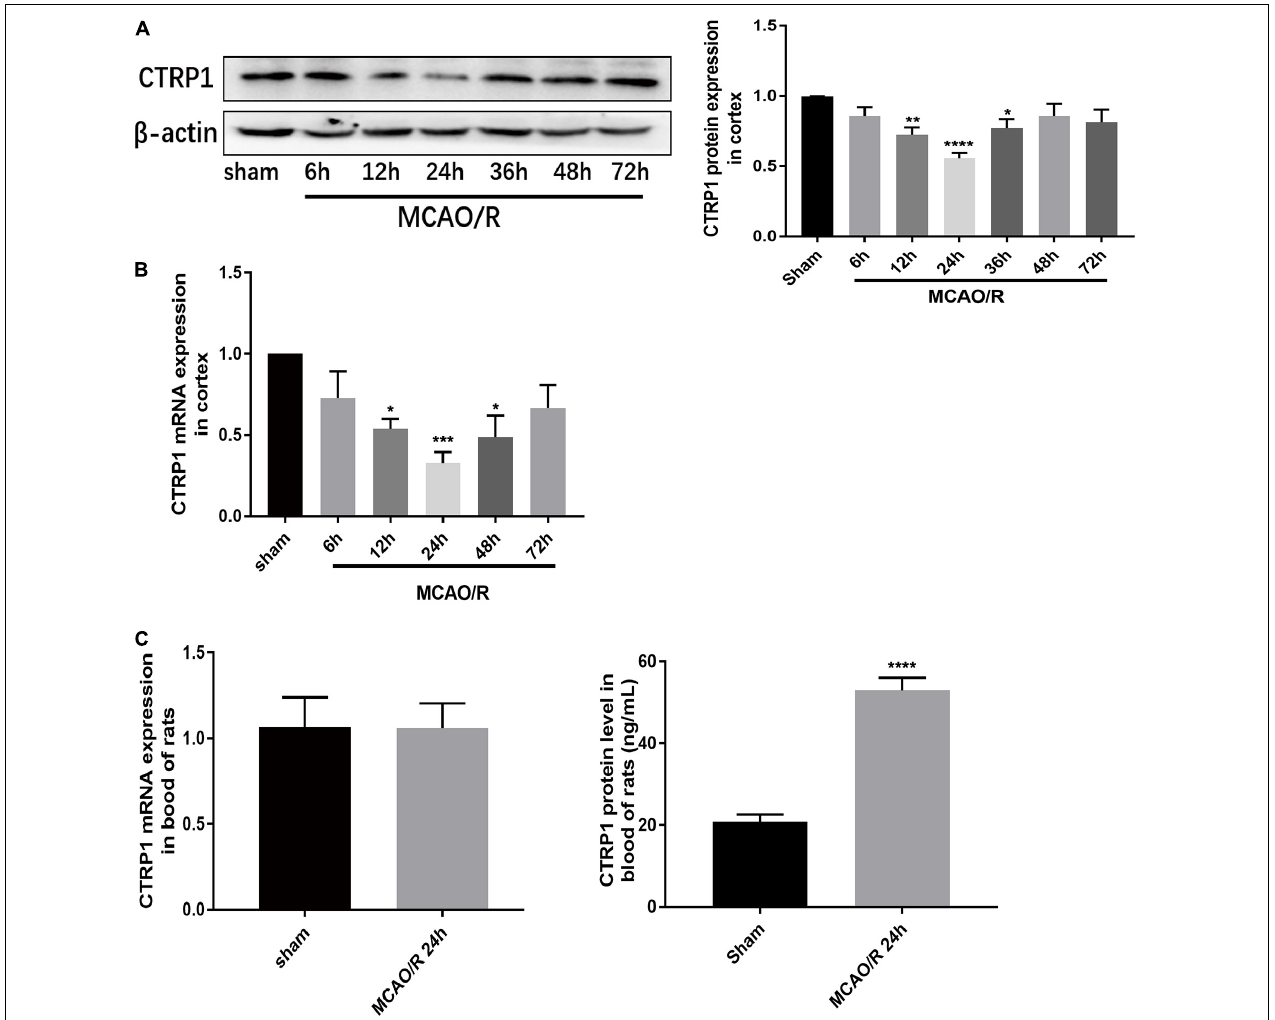
FIGURE 1 | Relative expression of CTRP1 in MCAO/R-treated rats. (A) Relative protein expression of CTRP1 in the cortex detected by Western blot, n = 4 per group. (B) Relative mRNA expression of CTRP1 at different times after MCAO/R in the cortex, n = 4 per group. (C) Relative mRNA expression and concentration of CTRP1 in the serum of MCAO/R rats detected by qRT-PCR and ELISA, n = 12 per group. **** p < 0.0001, *** p < 0.001, ** p < 0.001, * p < 0.05 vs. sham